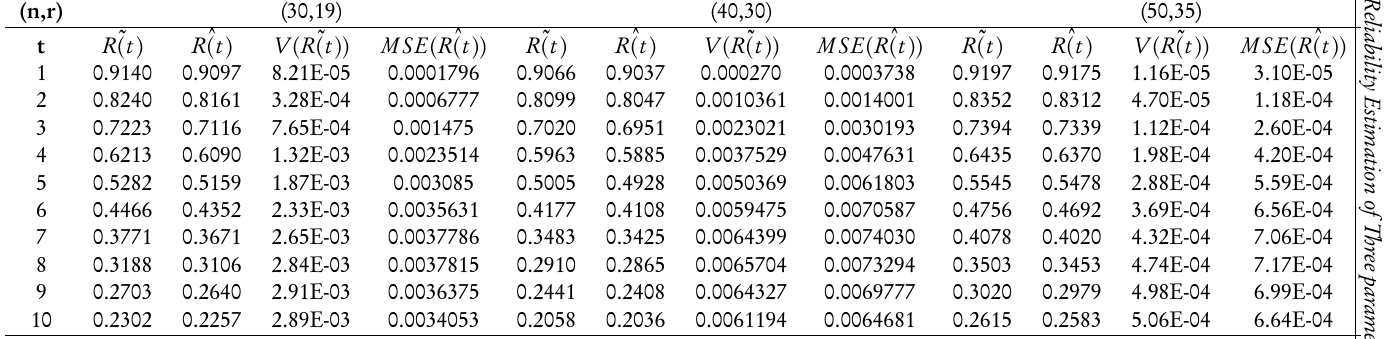
Estimates of R(t) and P, corresponding variances and MSE for different (n, t